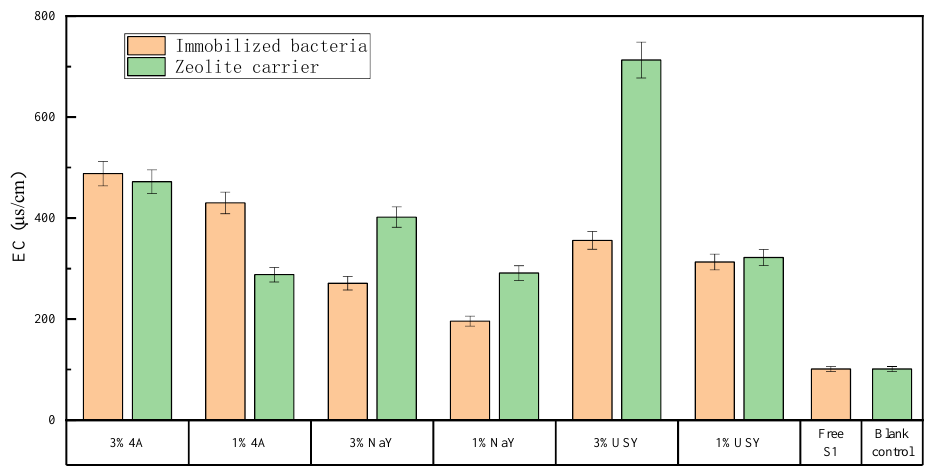
Figure 3. The effect of zeolite and bacteria on soil EC.